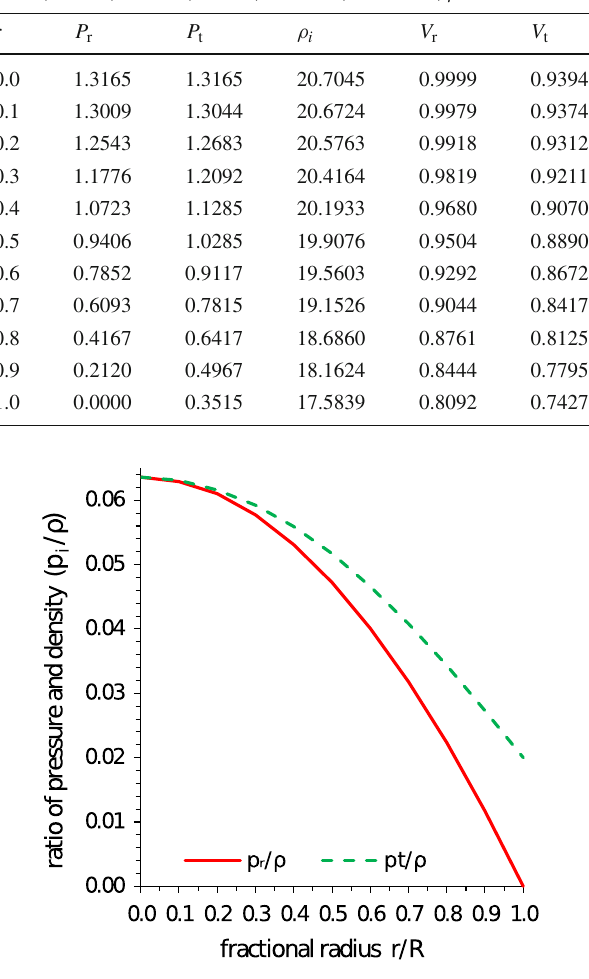
Fig. 5 Behavior of the ratios of pressure to density, p r /ρ and p t /ρ with respect to the fractional radial distance ( r / R ) for RX J 1856-37. Forplottingthisfigurewehaveemployedthesamedatasetofnumerical values as used in Figs. 1, 2, 3 and 4